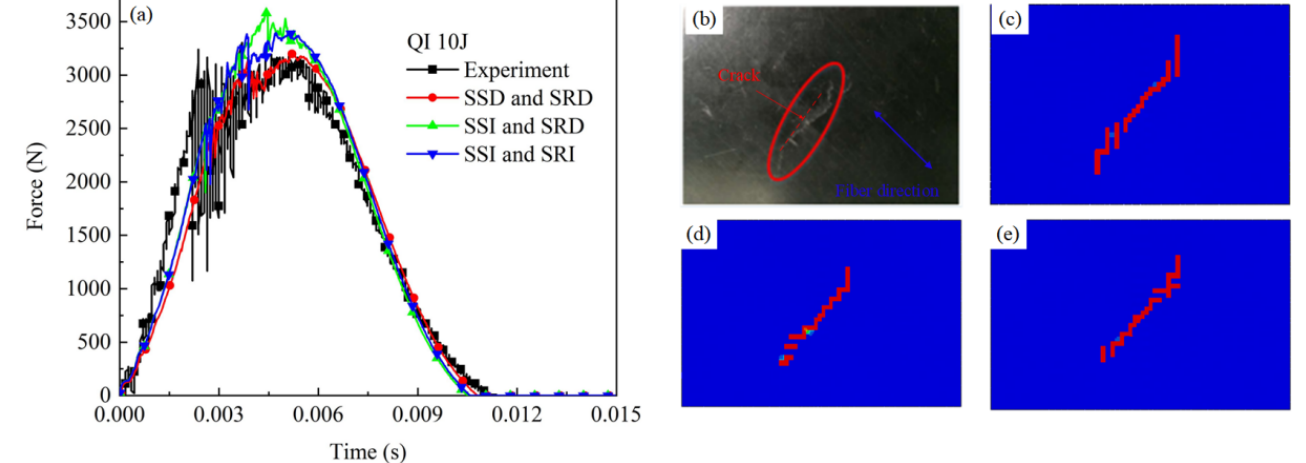
Figure 6. Comparison of experimental results and simulation results ( a ) contact force; ( b ) experi- mental failure pattern; ( c ) SSD and SRD ( d ) SSI and SRD ( e ) SSI and SRI simulation result.